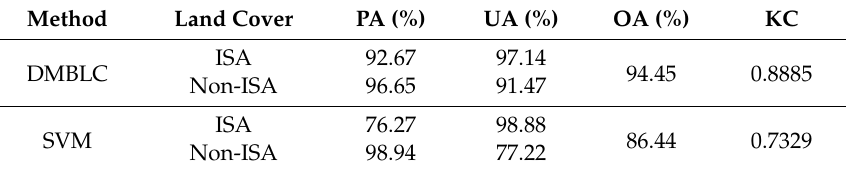
Non-ISA in Table 2 refers to vegetation and soil.